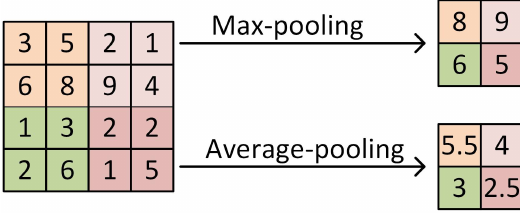
Figure 4. Example of pooling operations. The kernel size is 2 × 2 and the stride is 2 pixels.